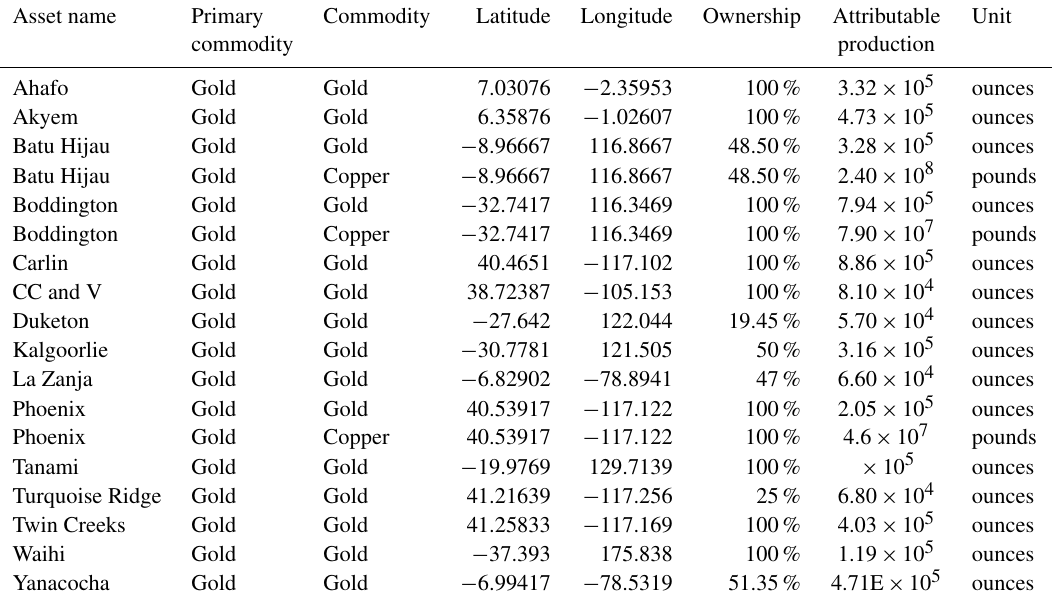
Table A3. Mining asset coordinates and attributable production per mine for Newmont Corporation for